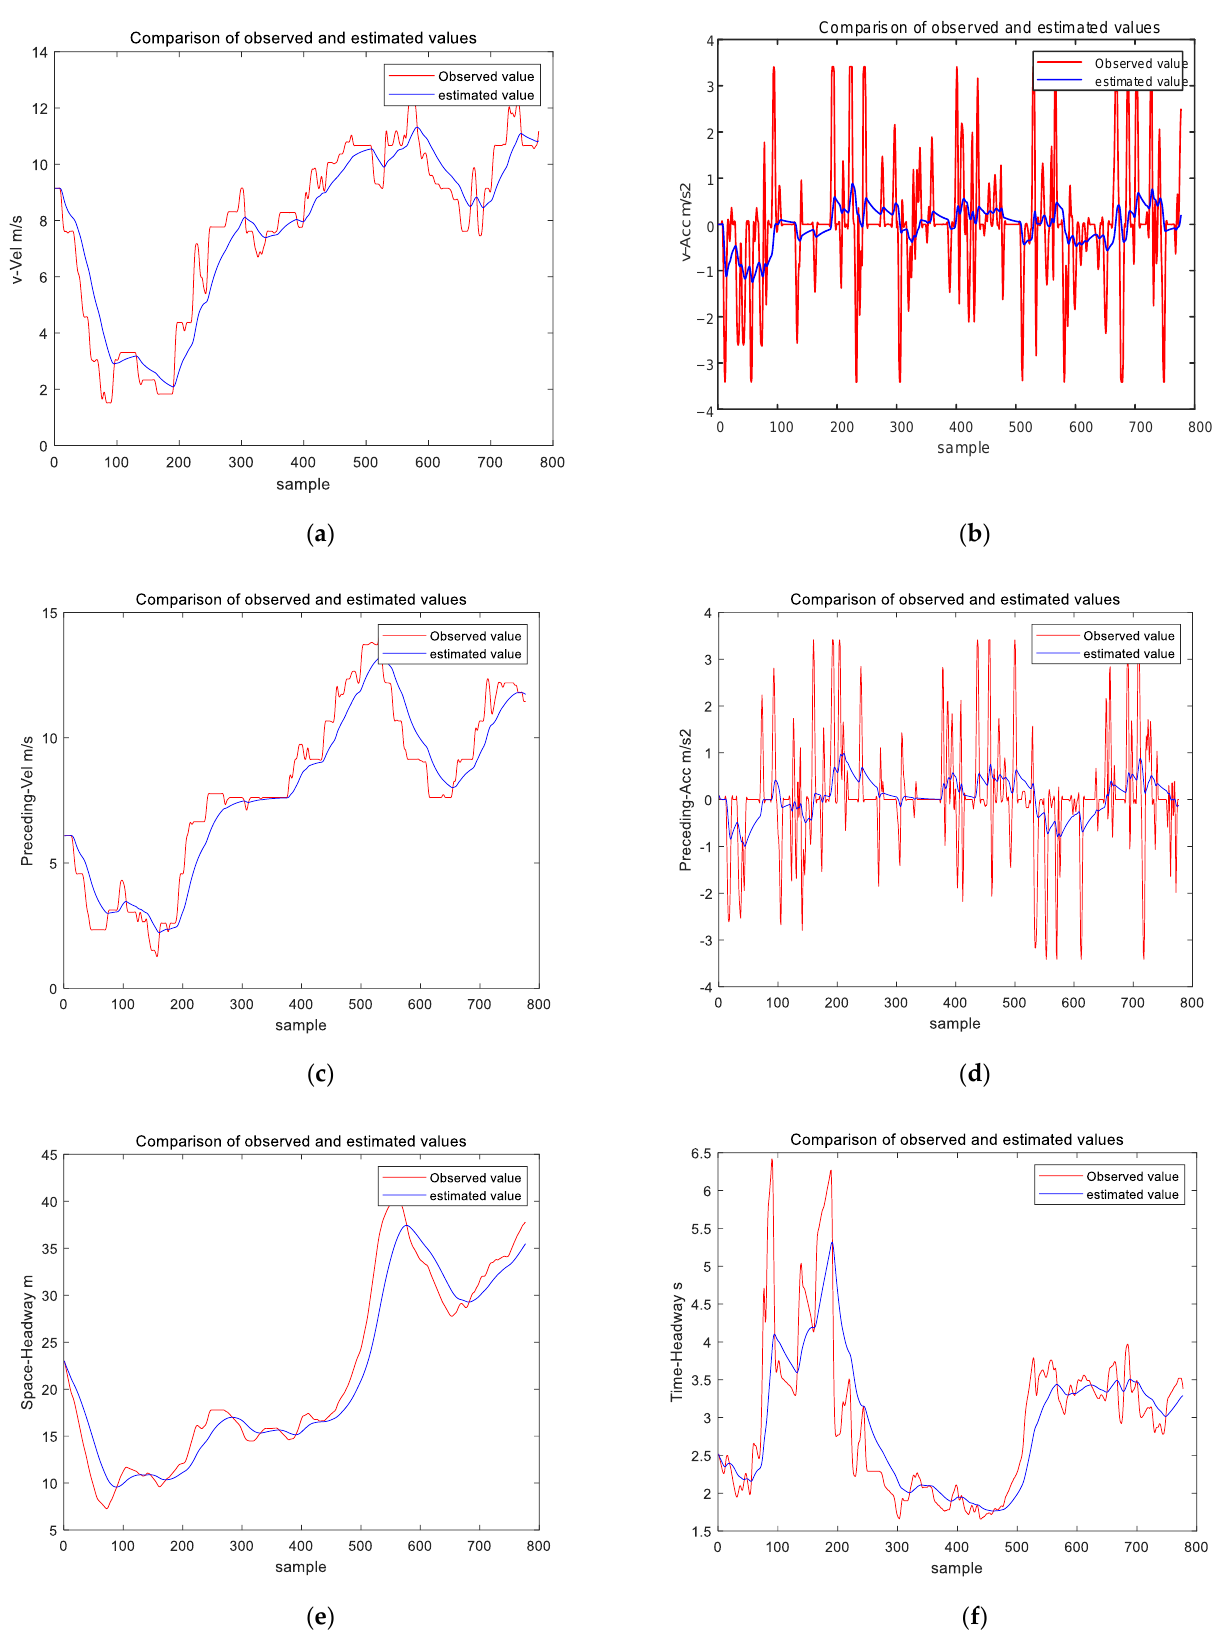
Figure 2. Comparison of the results before and after filtering. ( a ) v-Vel; ( b ) v-Acc; ( c ) Preceding-Vel; ( d ) Preceding-Acc; ( e ) Space-Headway; ( f ) Time-Headway.